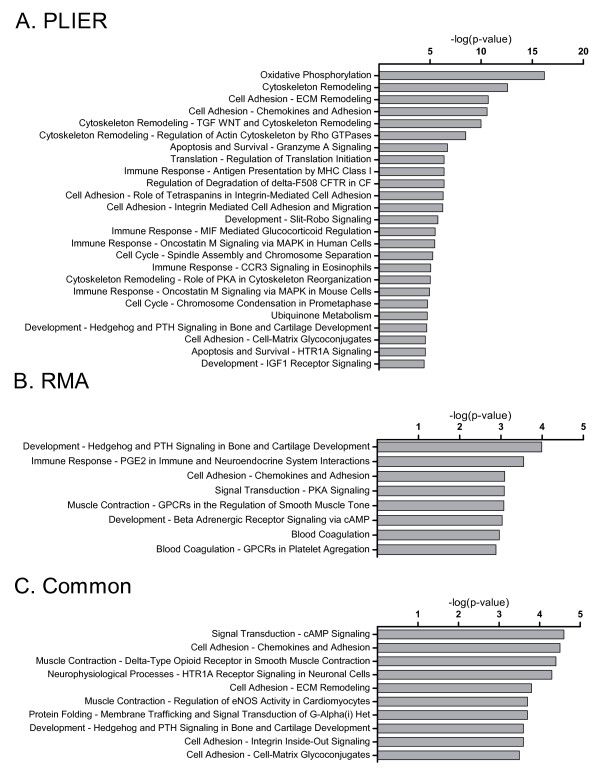
Pathway analysis, most significant pathways. Top ranked pathways from GeneGo MetaCore pathway analysis following probeset selection with GEDA's J5 metric. Pathways are ranked based upon p-value, bars represent inverse log of the p-value. (A) Top 25 pathways generated from PLIER preprocessed array data (of 69 meeting significance criteria of p < 0.001). (B) Eight significant pathways generated from RMA preprocessed array data. (C) Top ten significant pathways from an analysis considering only genes common to both RMA and PLIER scoops.